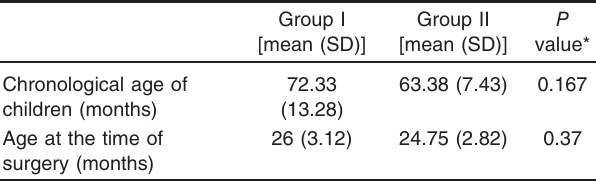
Table 1 Chronological age of children and age at the time of surgery